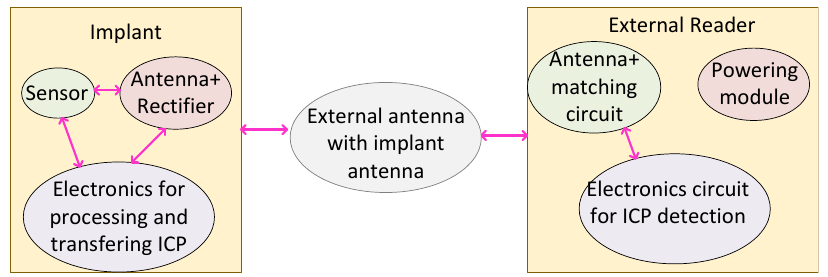
Figure 31. Remotely powered piezoresistive pressure Sensor for monitoring health